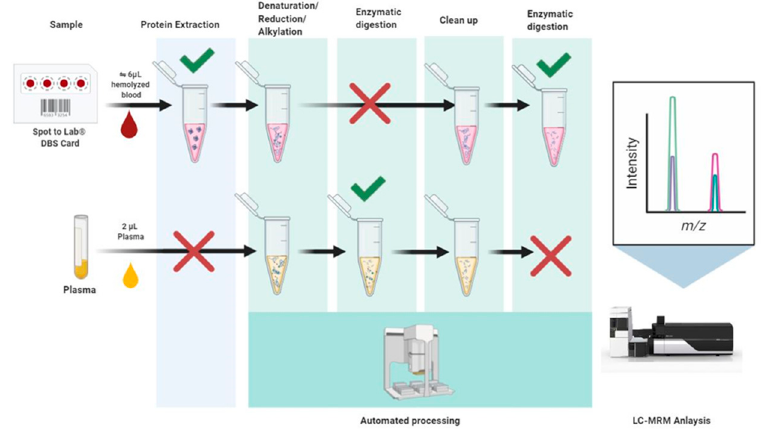
Figure 2. Generic workflow from plasma and DBS samples to LC-MS analysis. Generic representation of the sample preparation workflow before LC-MS analysis. After transferring to a 96-deep-well plate, multi-step sample preparations were performed on an AssayMap Bravo (Agilent Technologies, Lexington, KY, USA). A bottom-up approach was used to perform protein quantification by MS. To obtain optimal results, protein samples were extracted/denaturated/reduced and alkylated before the protein digestion with trypsin. Clean samples were then injected on the LC-MS instrument.